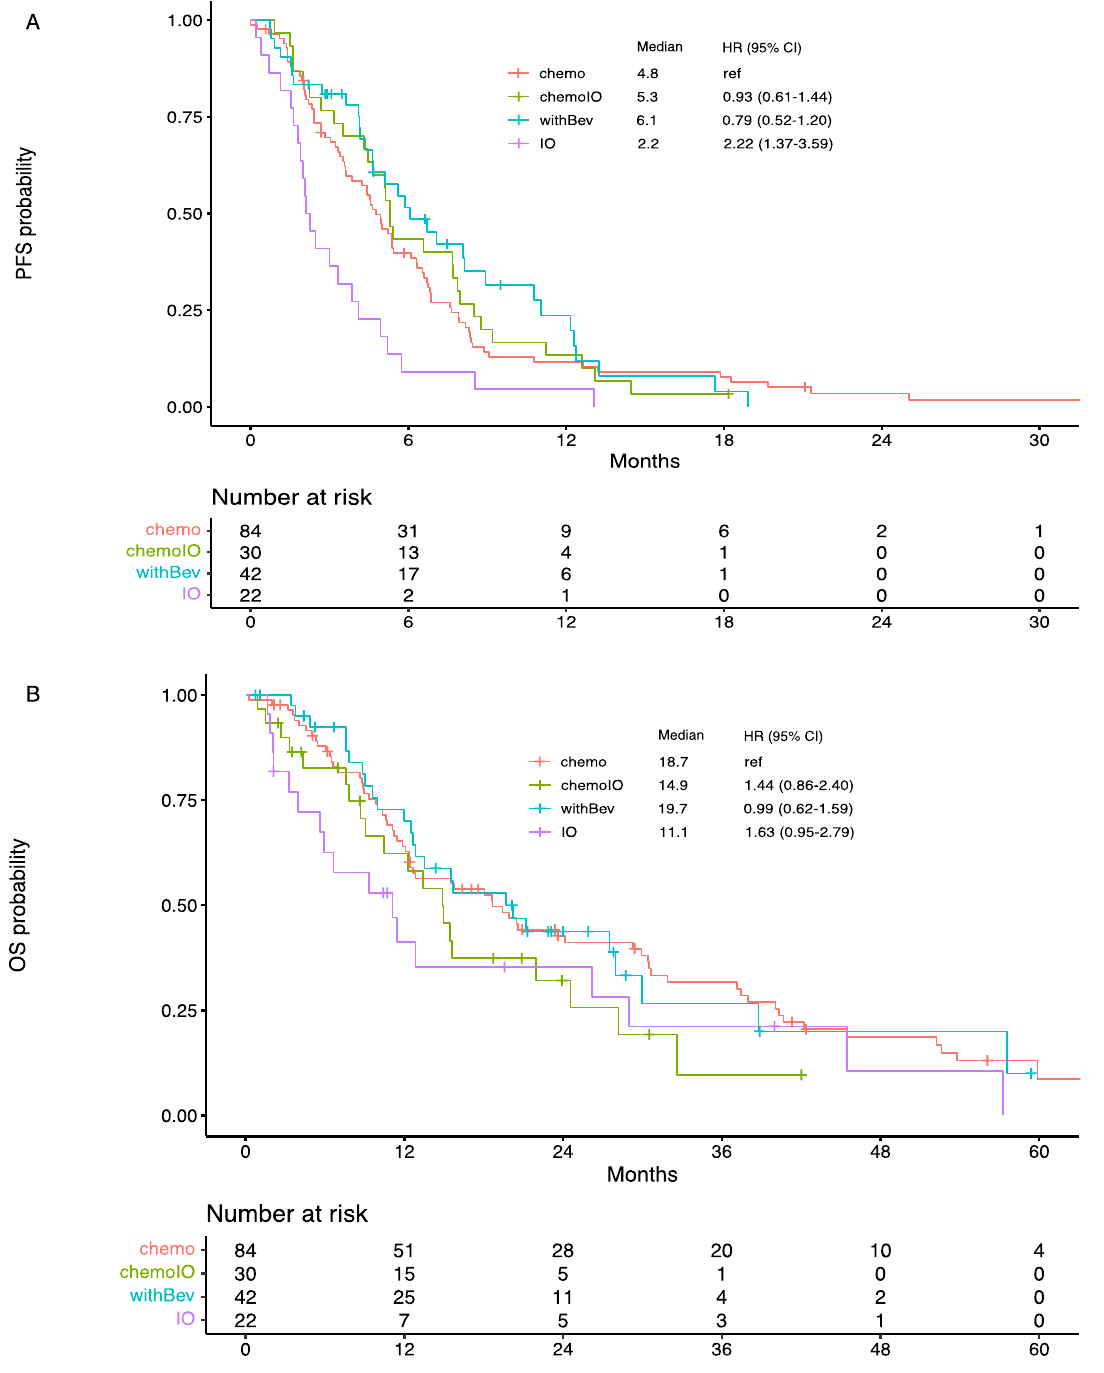
Figure 1. Clinical outcomes in TKI-refractory EGFR-mutant lung adenocarcinoma patients treated with subsequent regimen, including chemotherapy alone (chemo), chemotherapy combined with immunotherapy (chemoIO), chemotherapy plus bevacizumab with or without immunotherapy (withBev), and immunotherapy alone (IO). ( A ) Progression-free survival (PFS); ( B ) overall survival (OS). 3.3. Inferior Response in High-PD-L1 EGFR-Mutant LUAD Compared to EGFR-Wildtype LUAD For the 30 patients who received chemoIO (with or without Bev) with available PD-L1 status, we stratified PFS by PD-L1 expression levels: <1% (negative, n = 8), 1–49% (low, n = 16), ≥ 50% (high, n = 6). The mPFS was 4.6, 5.4, and 5.8 months respectively (Figure 2A), with no difference among the groups ( p = 0.76). In the same database